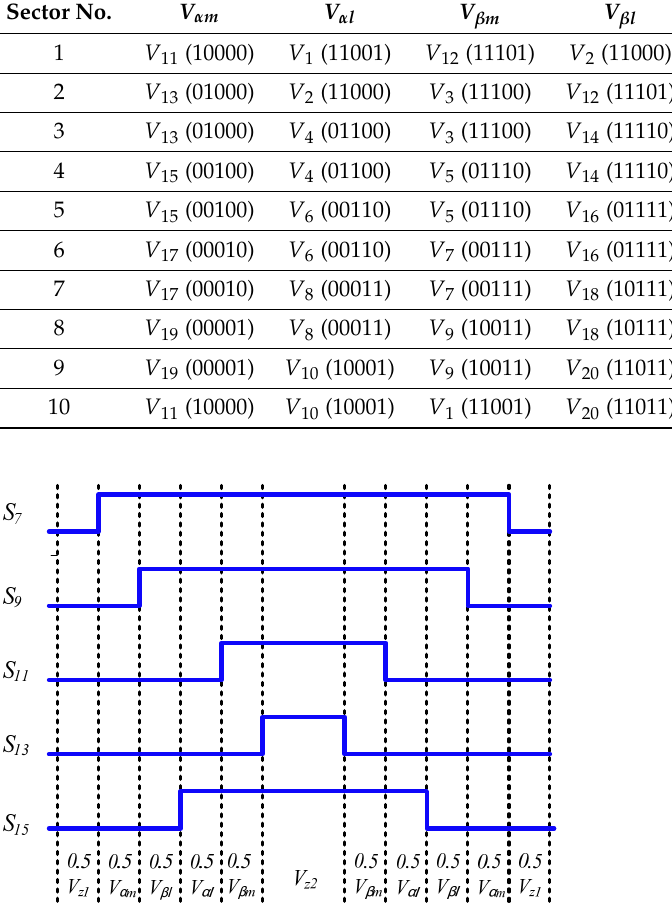
Table 2. Inverter’s switching vectors, which minimize switching losses in all sectors. Sector No.